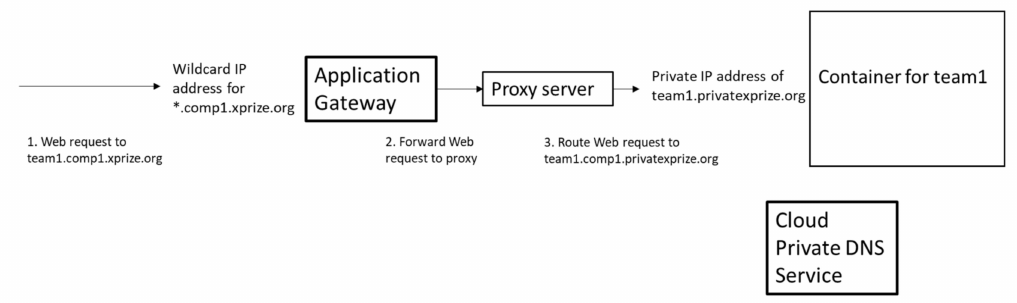
Figure 2. Routing of web requests to team notebook